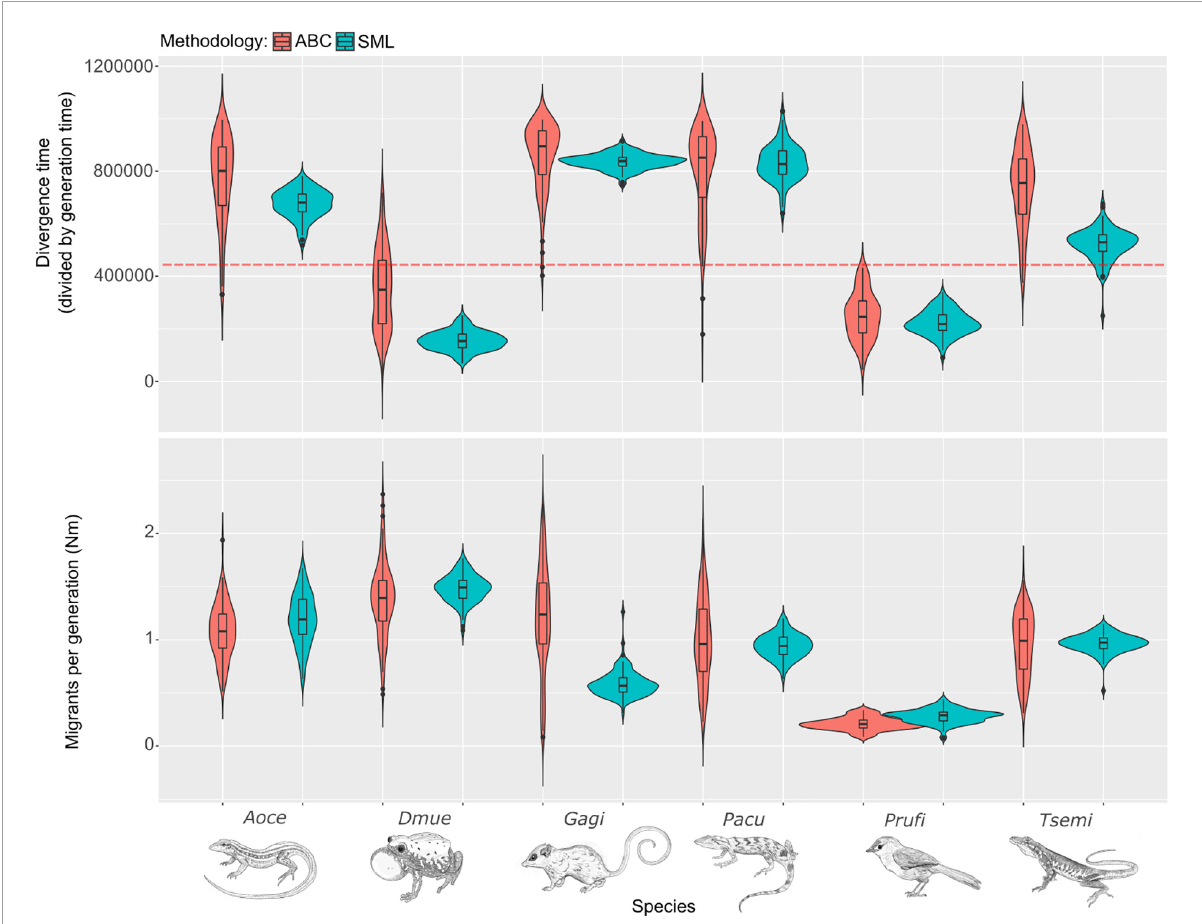
FIGURE3 Divergence time and migrants per generation estimated with approximate Bayesian computation (ABC) and supervised machine learning (SML) for each study species. Violins show the density of estimated values for each parameter. The dotted orange line marks ∼ 450 kya. Boxplots within violins show median, first and third quartile, and minimum and maximum values estimated. Nm, number of migrants; Aoce , Ameivula ocellifera ; Dmue , Dermatonotus muelleri ; Gagi , Gracilinanus agilis ; Pacu , Polychrus acutirostris ; Prufi, Phacellodomus rufifrons ; Tsemi, Tropidurus semitaeniatus .